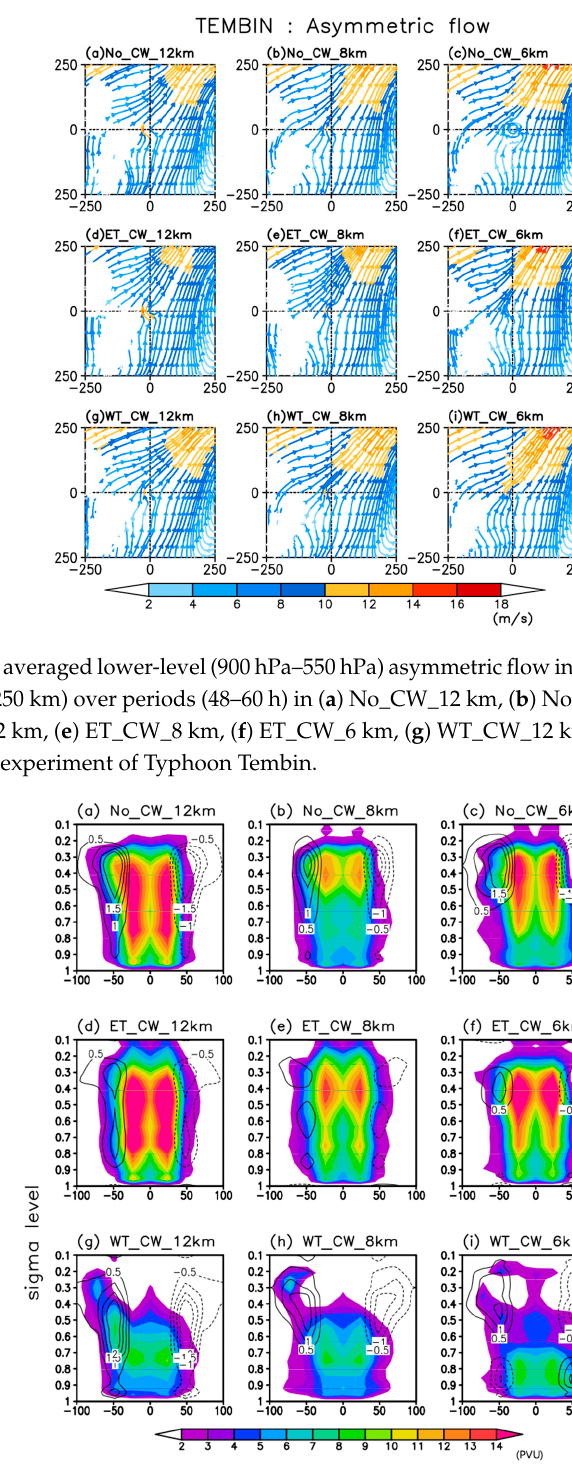
Figure 7. 12-h averaged zonal cross-section of PV at the center of TC during 48–60 h in ( a ) No_CW_12 km, ( b ) No_CW_8 km, ( c ) No_CW_6 km, ( d ) ET_CW_12 km, ( e ) ET_CW_8 km, ( f ) ET_CW_6 km, ( g ) WT_CW_12 km, ( h ) WT_CW_8 km and ( i ) WT_CW_6 km.Shaded is the PV magnitude in No_CW (top), ET_CW (middle), and WT_CW (bottom), the shading denotes the magnitude of PV and contour denotes wavenumber 1 component of PV(shaded interval is 1 PVU:10 − 6 m 2 s − 1 Kkg − 1 and the contour interval is 0.5